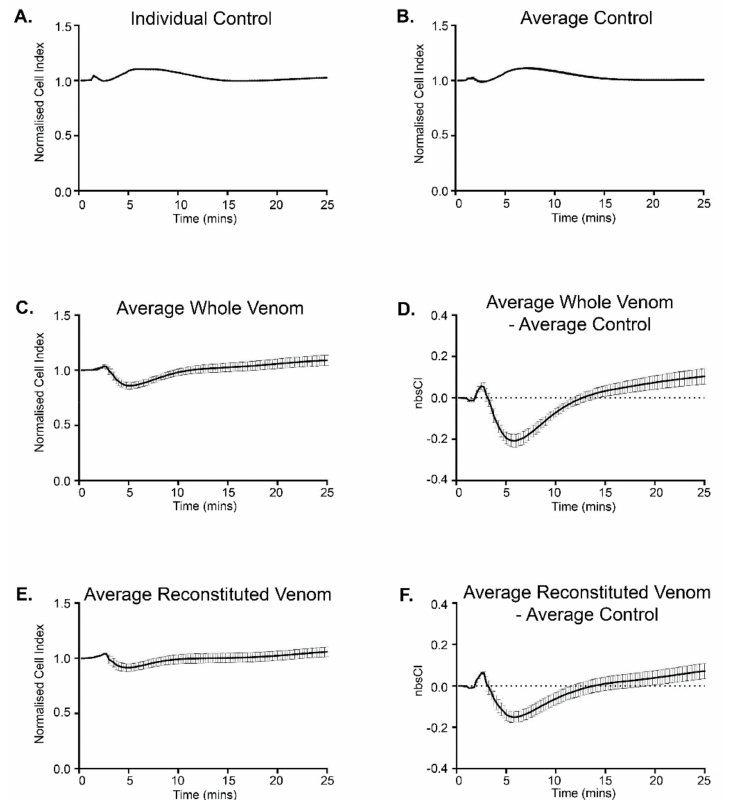
Figure 2. xCELLigence data showing changes in GCaMP5G-RyR1-HEK293 monolayer impedance (normalised cell index (CI)) in response to application of control, whole venom or reconstituted venom from the Australian scorpion Hormurus waigiensis . ( A ) The e ff ect of adding a sample of the background control (SE-FPLC phosphate bu ff ered saline) to a single well containing rHEK293 cells reflects the sensitivity to fluid changes. ( B ) Average of the background control responses. ( C ) Average response followingapplicationofwholevenom. ( D )Averagewholevenomresponsecorrectedforthebackground (average whole venom—average control). ( E ) Average response of the reconstituted scorpion venom. ( F ) Corrected response for reconstituted venom (average reconstituted venom—average control). For ( D ) and ( F ), nbsCI = average normalized background subtracted CI. Plots ( B )–( F ) show mean ± s.e.m.; error bars in ( B ) are not evident due to the minimal variance ( n = 8); n = 6 for each